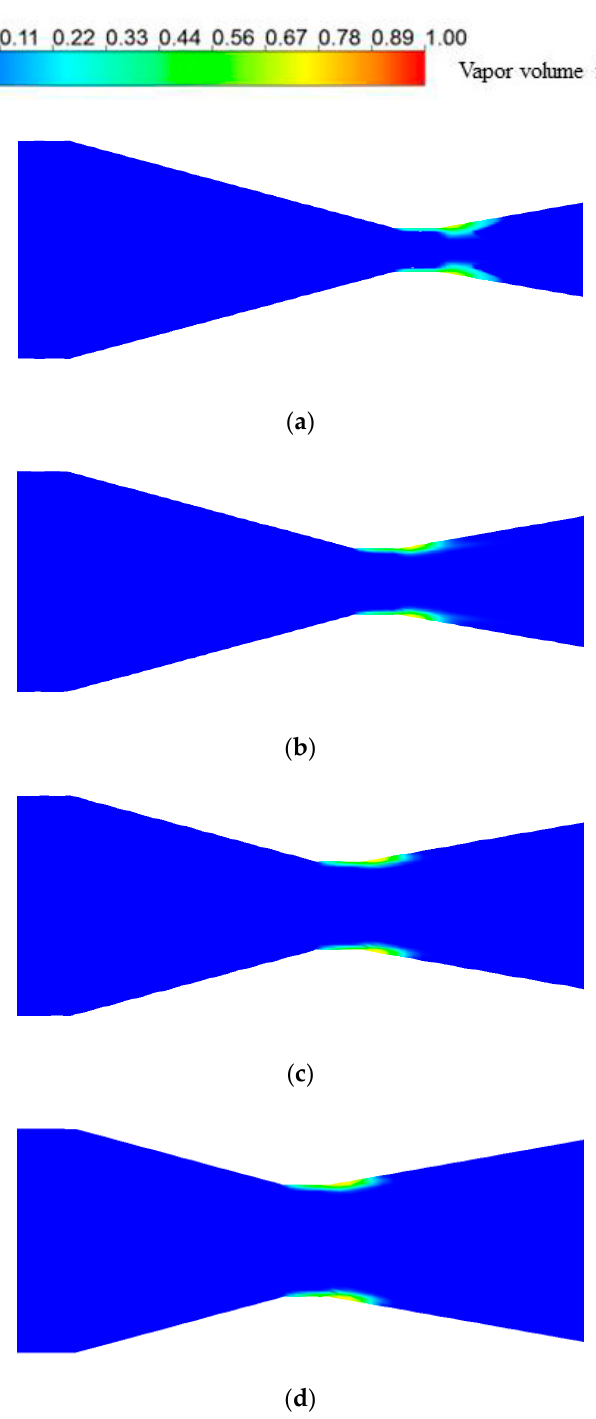
Figure 11. Contour of vapor volume fraction of the Venturi tube with different contraction ratios, ( a ) 0.1, ( b ) 0.2, ( c ) 0.3, ( d ) 0.4.